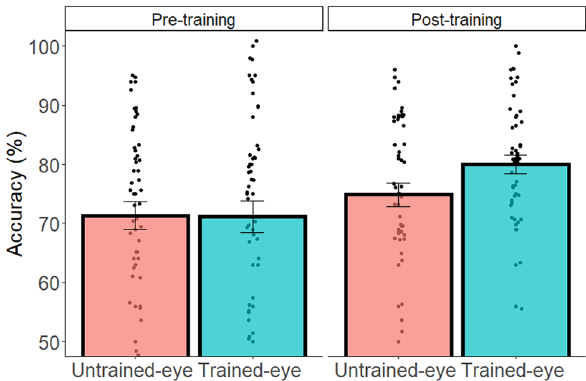
Figure 5. Accuracy for each individual (dot) as a function of Eye and Experimental Stage in novel subtraction problems. Error bars represent